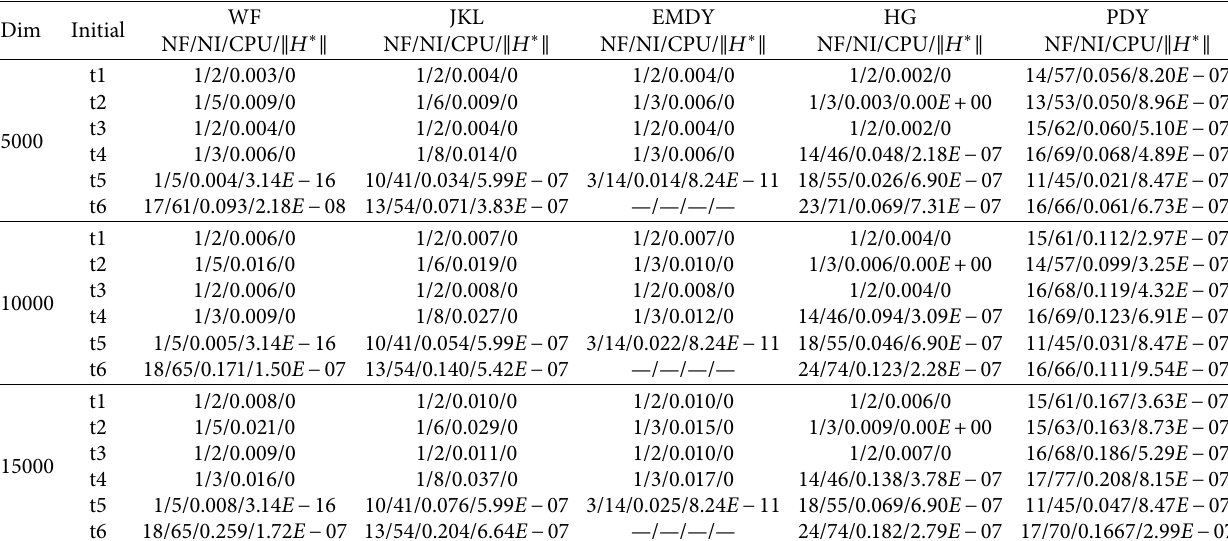
Table 6: Numerical results on problem